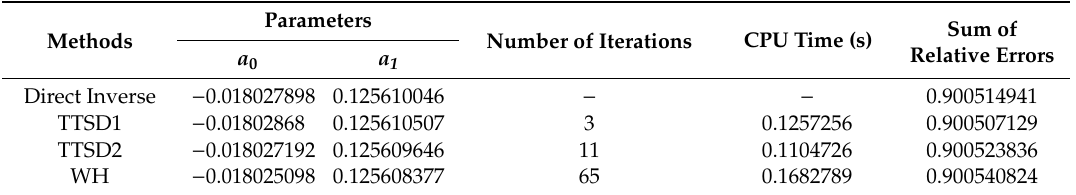
Table 3. Summary of